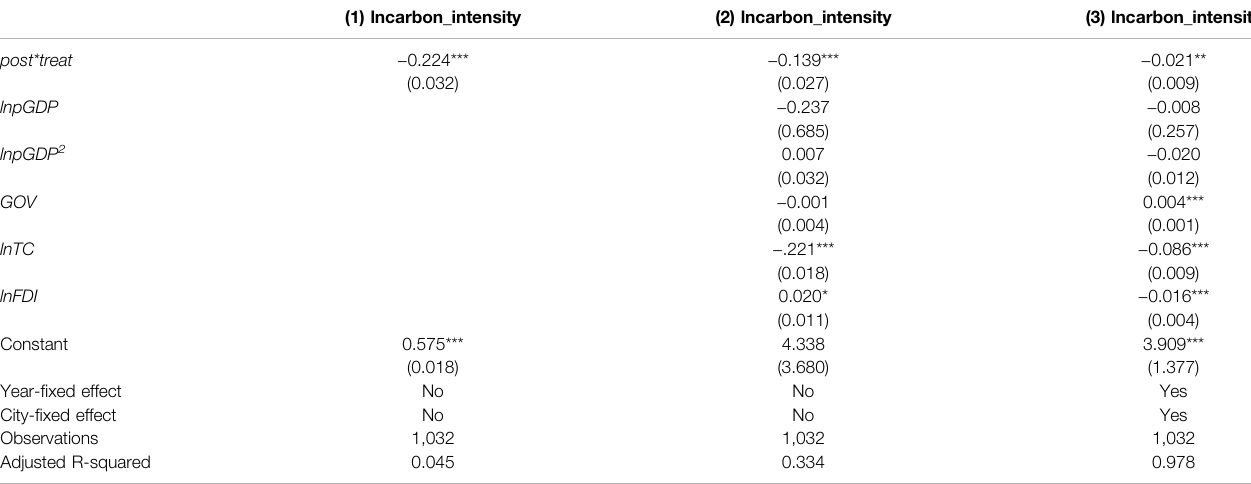
TABLE 9 | Regression results excluding the in fl uence of other policies.